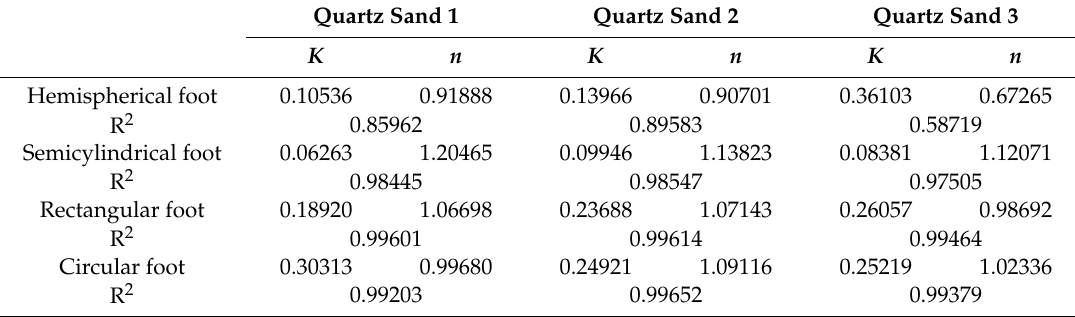
Table 4. Intrusion model coefficients.